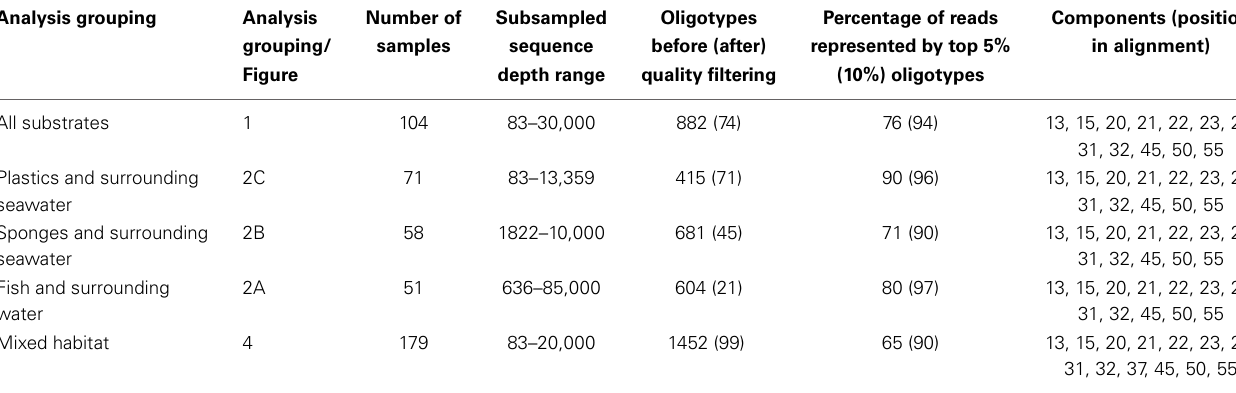
Table 2 | Description of samples for each analysis